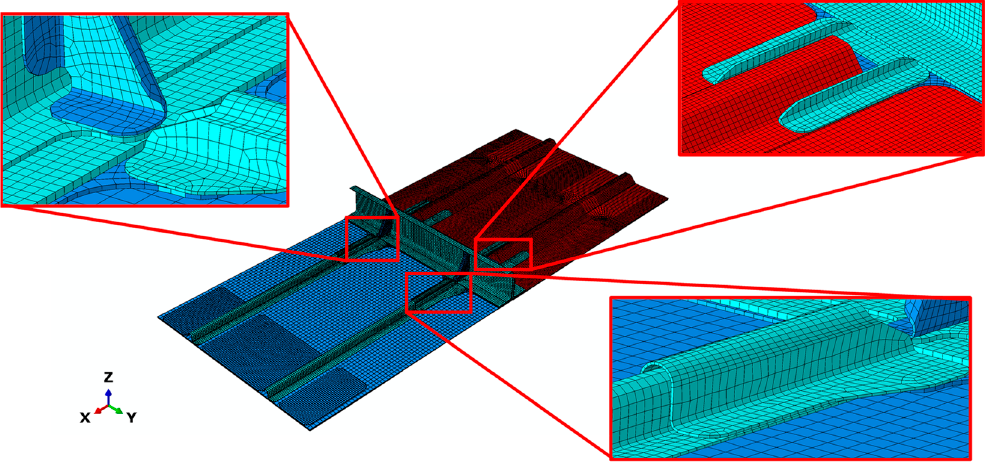
Figure 8. Finite element model (FEM).